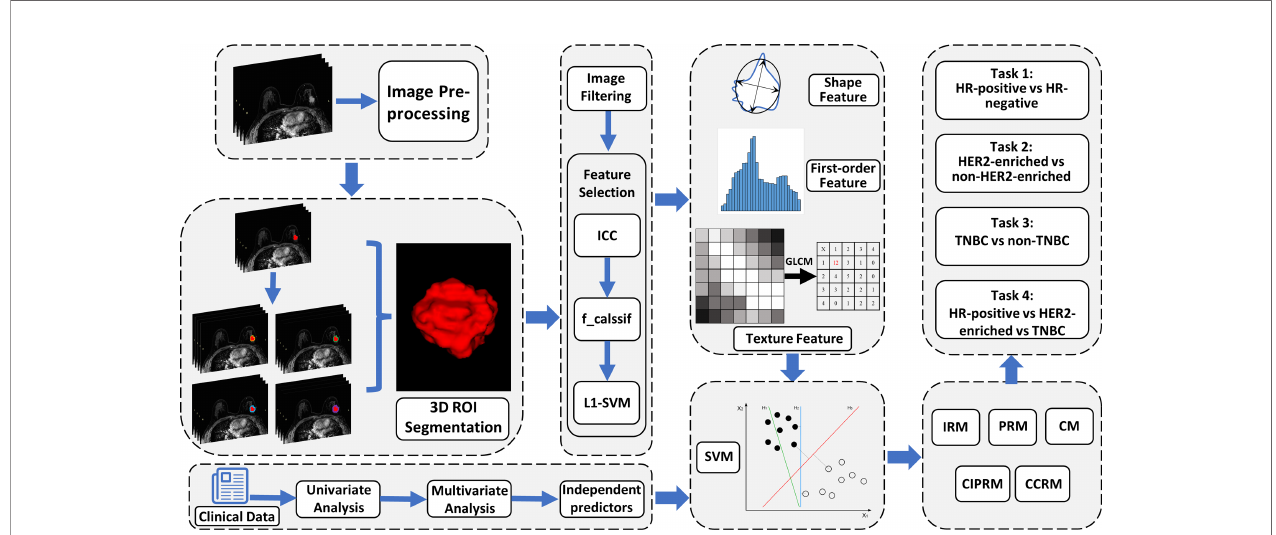
FIGURE 3 | An overview of radiomics analysis methodology in this study. Five predictive models were developed based on clinical – radiological characteristics and intratumoral and peritumoral radiomics features. CM, clinical – radiological model; IRM, intratumoral radiomics model; PRM, peritumoral radiomics model; CIPRM,